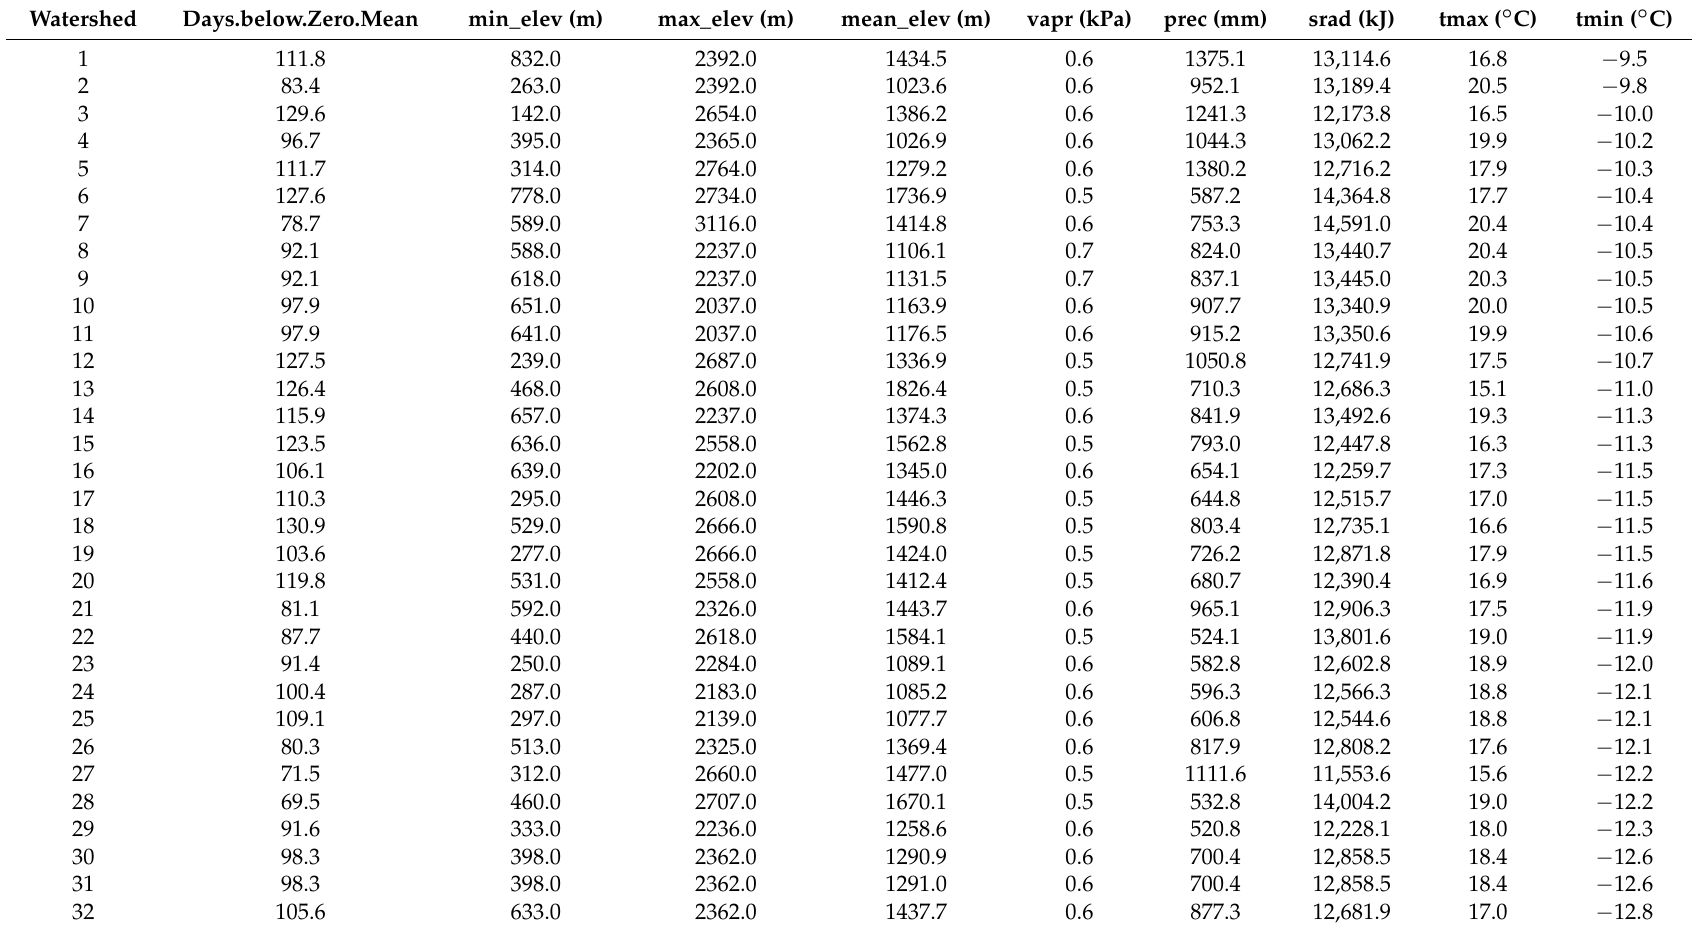
Table A2. Raw data used for PCA